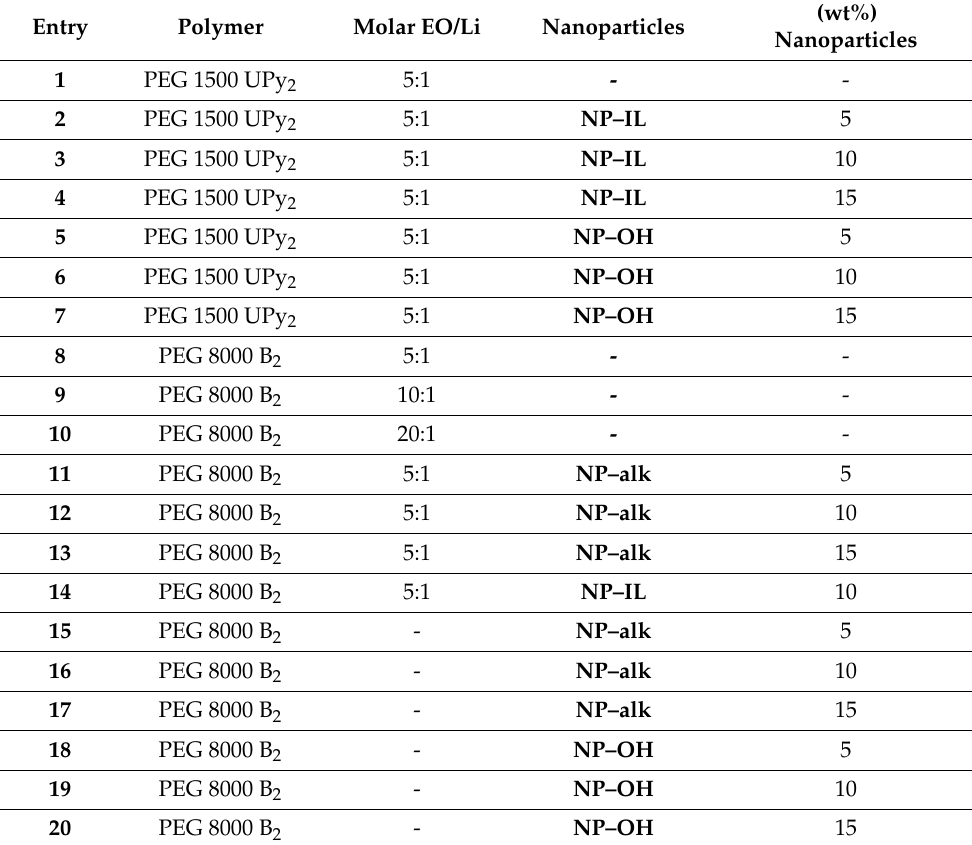
Table 1. Electrolyte compositions prepared form PEG 1500 UPy 2 and PEG 8000 B 2